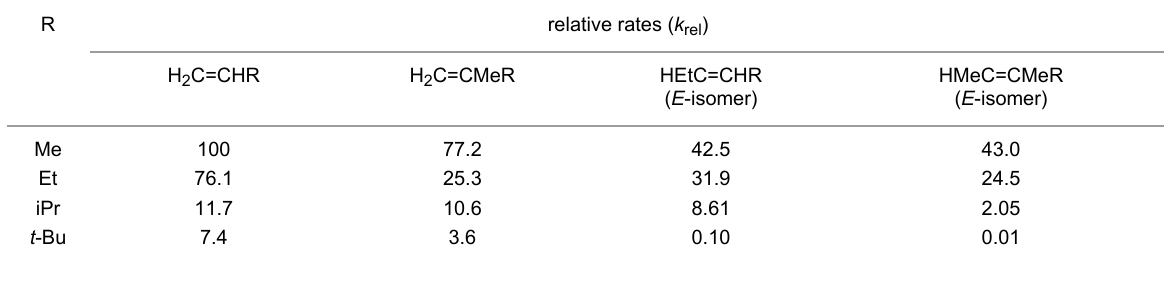
Table 3: Effect of substituent branching upon PhSeCl addition in alkene